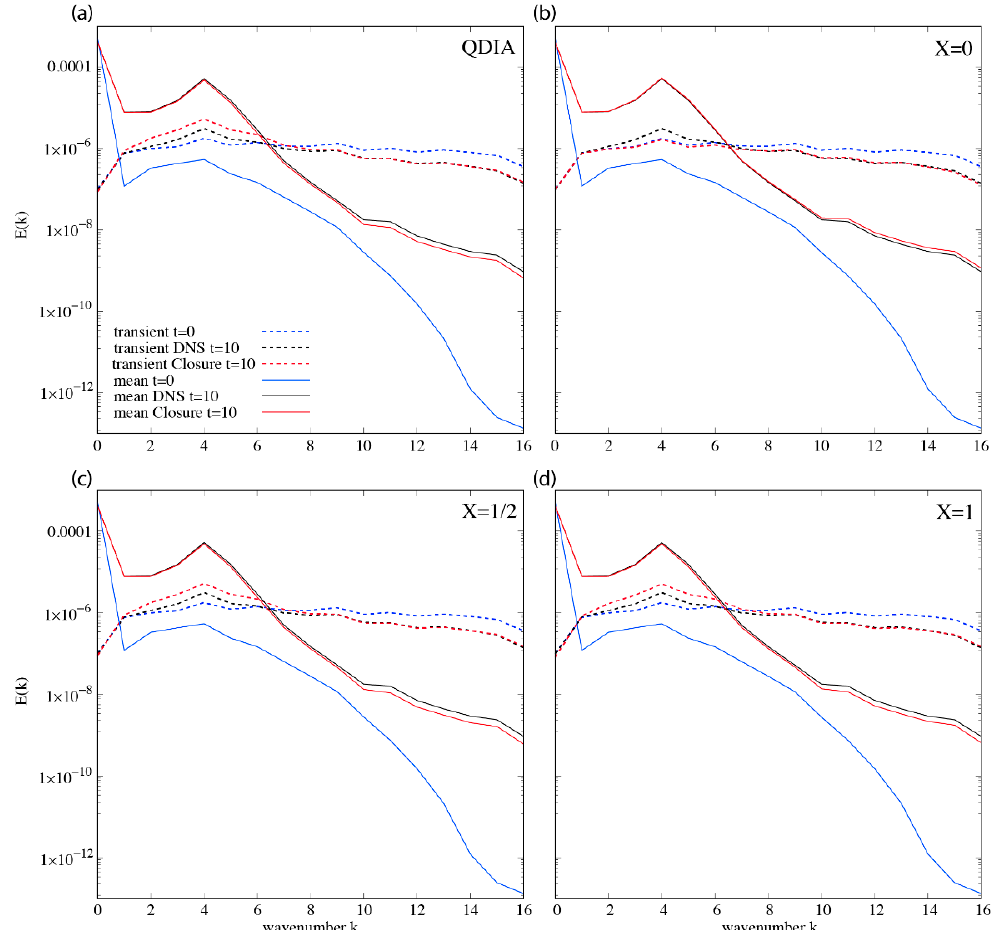
Figure 2. The initial and evolved non-dimensional kinetic energy spectra for the four inhomogeneous abridged closures ( a ) QDIA [ ζ ( t )] , ( b ) MIC X = 0 [ ζ ( t )] , ( c ) MIC X = 1 2 [ ζ ( t )] , ( d ) MIC X = 1 [ ζ ( t )] , and the ensemble of DNS on each figure part. Shown are: initial mean energy (solid blue), initial transient energy (dashed blue), evolved DNS mean energy (solid black), evolved DNS transient energy (dashed black), evolved closure mean energy (solid red), and evolved closure transient energy (dashed red). Multiply by